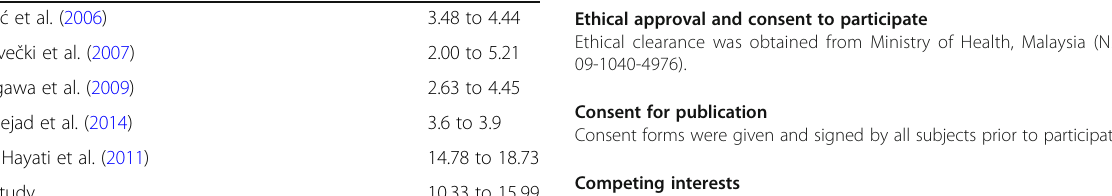
Paired Differences